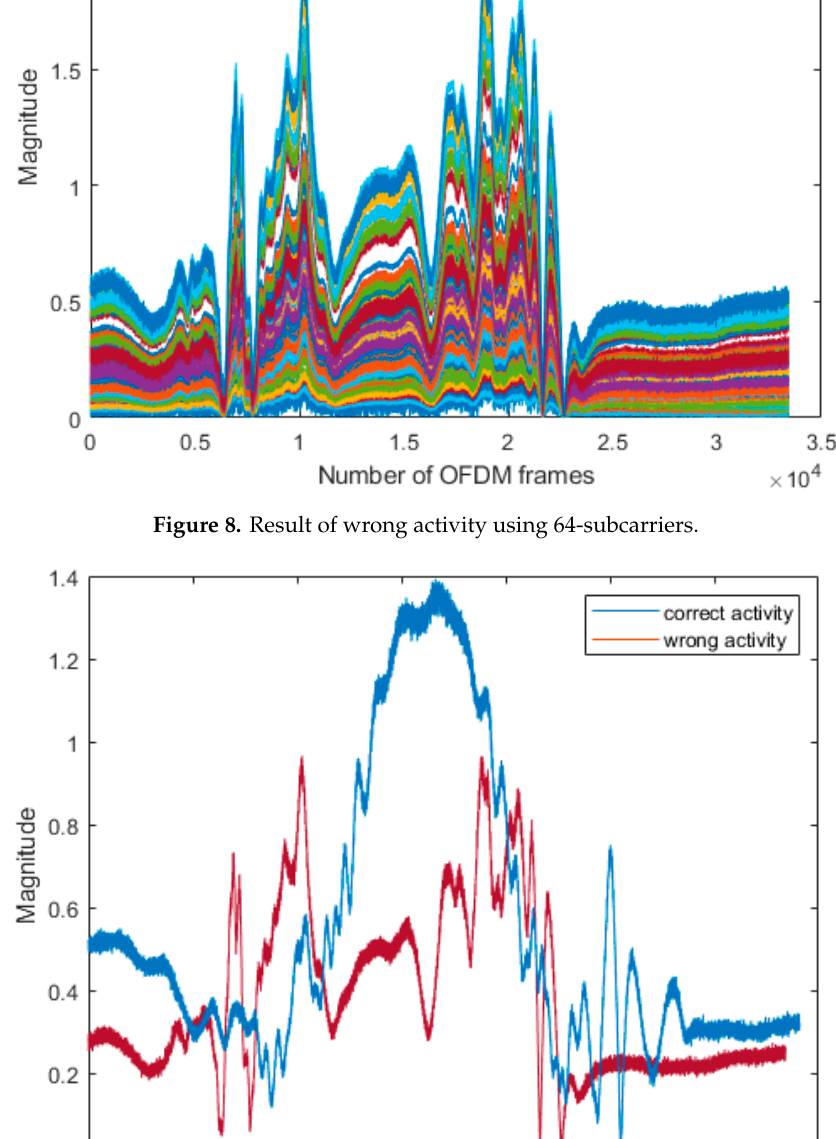
Figure 9. The comparison between the correct and wrong activities.